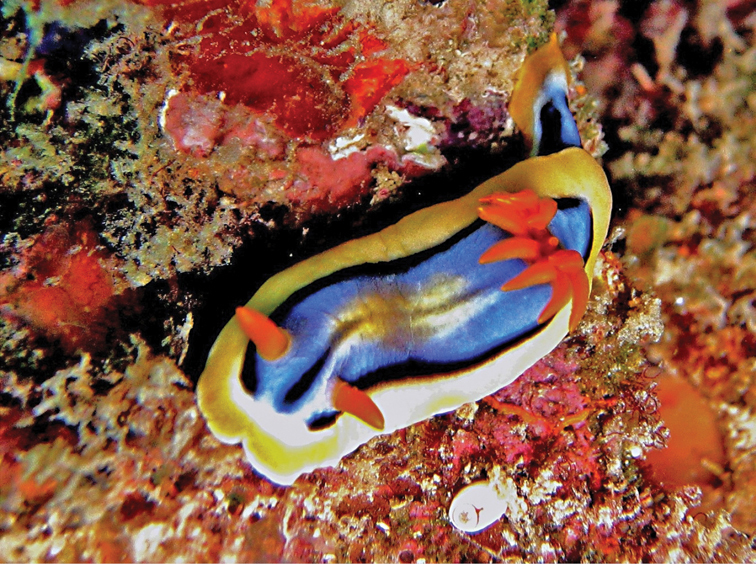
Chromodoris hamiltoni, Tanzania, photo: A de Villiers (no spcm).